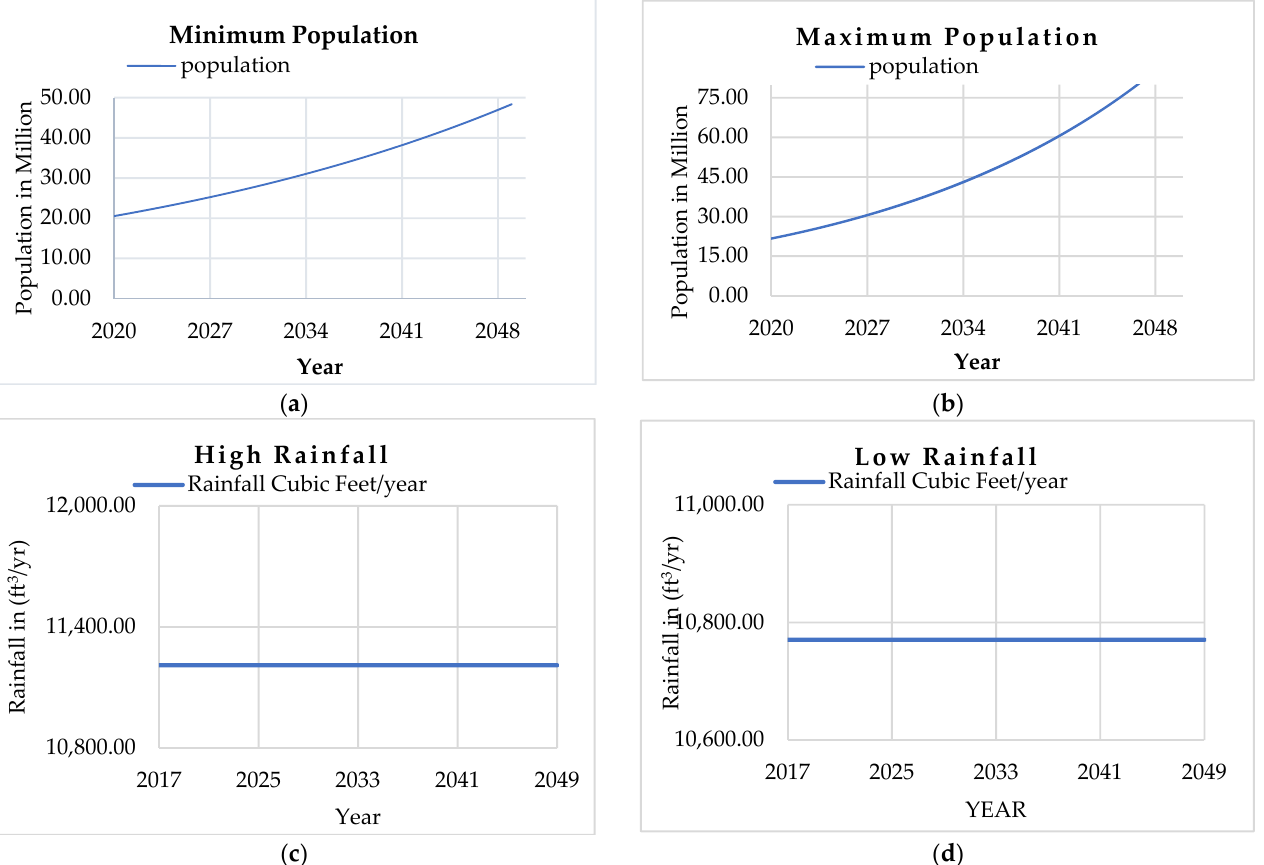
Figure 10. Simulated scenarios comparison ( a ) maximum population growth; ( b ) minimum population growth; ( c ) high rainfall; ( d ) low rainfall.